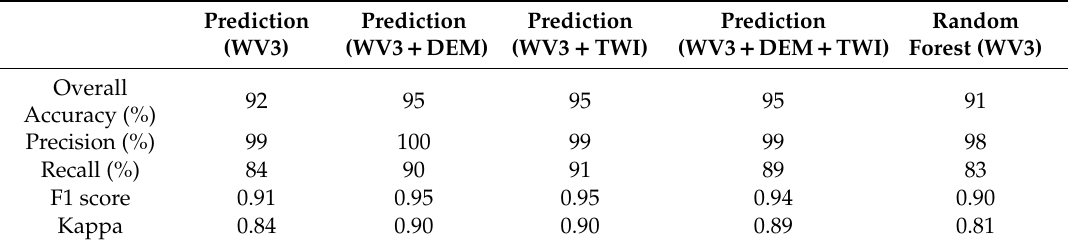
Table 2. Accuracy assessments using field data. The variables in the parentheses are the data input used for our deep learning network or the random forest model. WV3: WorldVview-3, DEM: Digital Elevation Model, TWI: Topographic Wetness